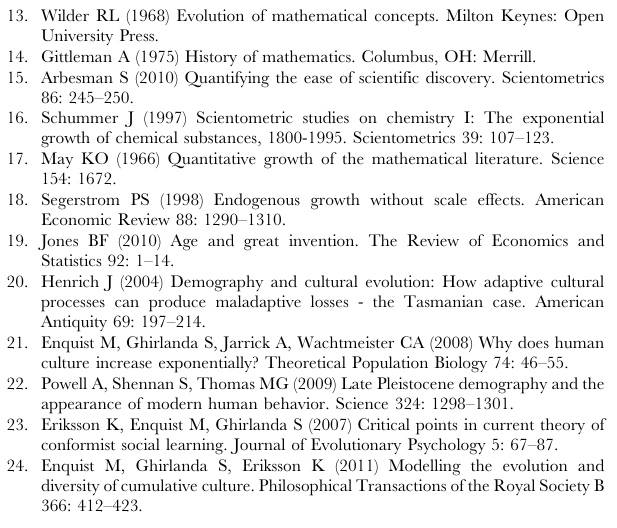
Table S1 Exact dates and ages plotted in Figure 2A.